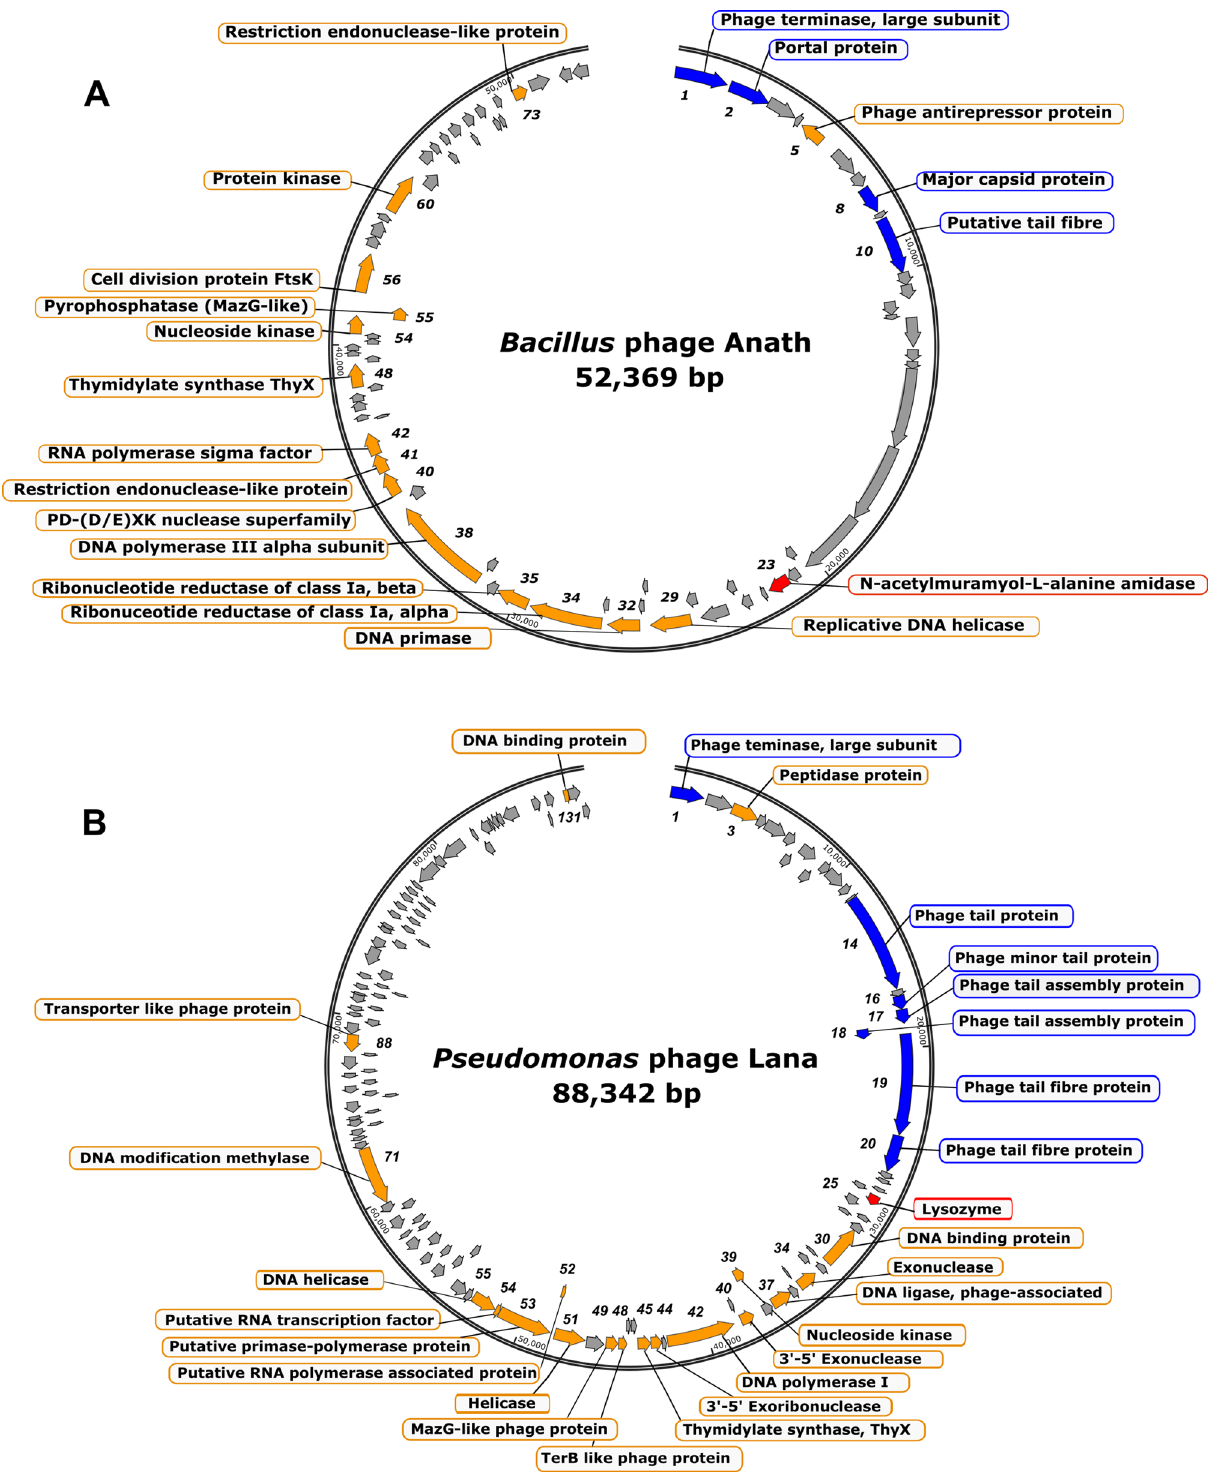
Figure 2. Genome structure of phage Anath ( A ) and phage Lana ( B ) with annotated putative protein functions (outside) and their gene product no. (inside). Structural genes are labelled blue and the lytic gene in red. Genes encoding hypothetical proteins are shown as